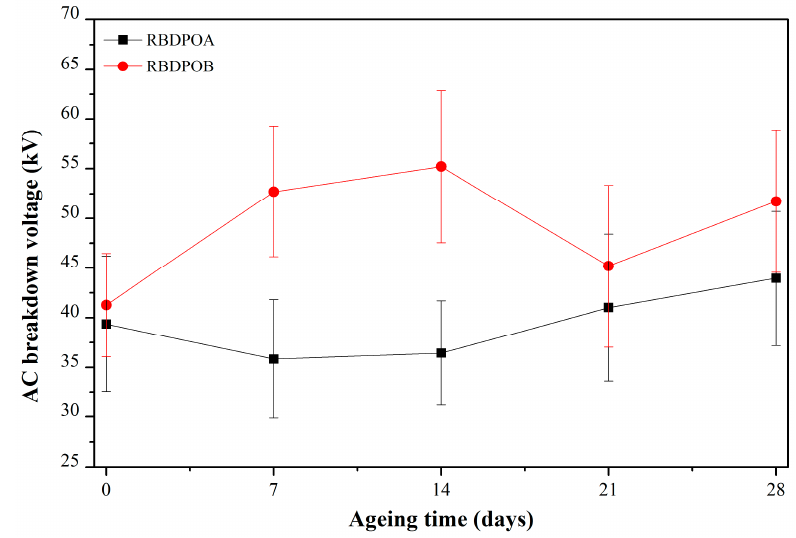
Figure 4. AC breakdown voltage of RBDPO aged at 170 °C under open conditions.